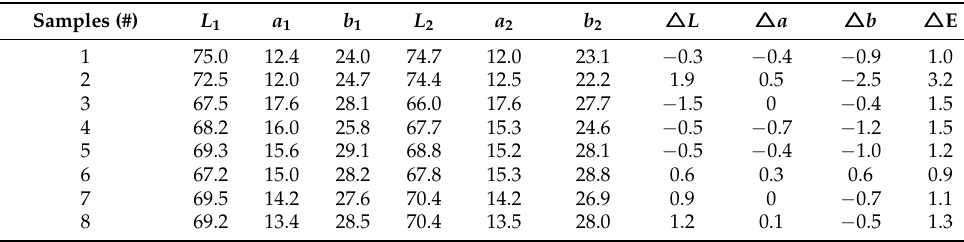
Table 2. Influence of coating processes on chromatic aberration of waterborne coating containing microcapsules.